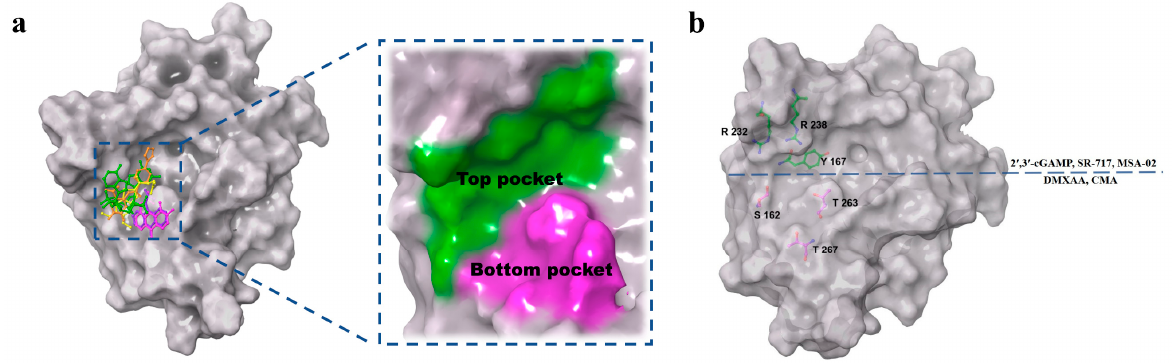
Figure 4. Subdivision of the STING binding sites and distribution with key amino acids. ( a ) Location of two regions in STING monomer. The bottom pocket is colored magenta and top pocket is green. The PDB codes for the overlapping crystal complexes are as follows: 4LOH (cGAMP, green), 6UKV (MSA-02, yellow), 6XNP (SR717, orange), 4LOL (DMXAA, magenta) and 4JC5 (CMA, purple). ( b ) Distributions of key amino acids in the top and bottom regions. The residues in the bottom pocket are shown in magenta, and the green ones are in the top region.